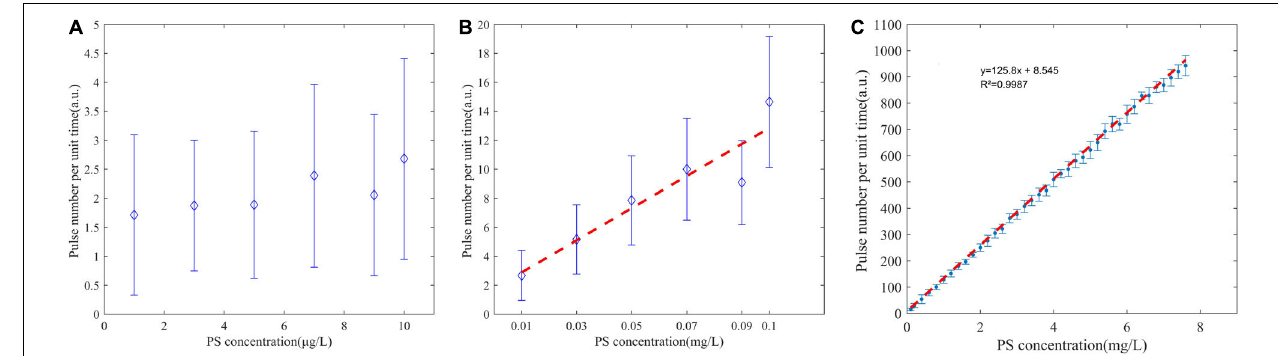
FIGURE 7 | The relationship between the concentration of 10-micron spherical polystyrene (PS) and the pulse number per unit time. (A) The pulse number per unit time when the concentration is in the range of 1–10 µ g/L. (B) The pulse number per unit time when the concentration is in the range of 0.01–0.1 mg/L. (C) The pulse number per unit time when the concentration is in the range of 0.1–8